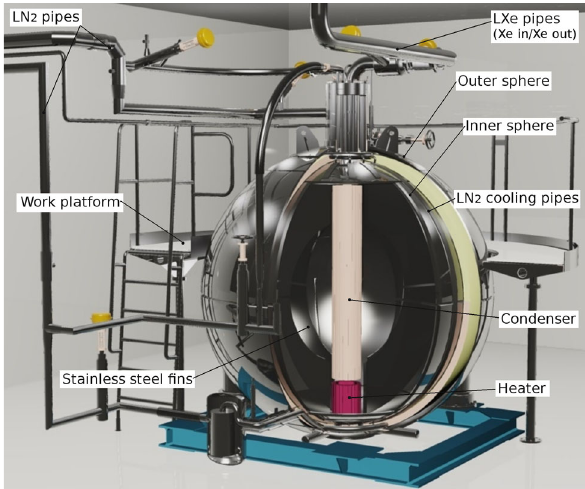
Fig. 10 Drawing of the xenon storage facility ReStoX, which can hold upto7.6tofxenoninliquidorgaseousstate.Thecondenserinthecenter of the 2.1m diameter sphere provides > 3kW of cooling power (for purification of the gas in ReStoX). The latter also pro- vides access to the distillation column (for 85 Kr removal, see Sect. 2.2.3). All components of the gas-handling sys- tem, their relative placement and connections are shown in Fig. 9. ReStoX is installed on the ground floor, about 7m below the top of the detector. The pumps of the purifica- tion system are used to transfer the xenon into the cryostat in a controlled way, at a speed of up to 50slpm: the LXe is evaporated in the ReStoX heat exchanger, purified, re- condensed in the same exchanger and transferred to the cryo- stat. The recovery of xenon into ReStoX via direct vacuum- insulated lines is driven by the pressure difference in the two systems. In case of emergency or for any recupera- tion of Xe gas, the detector pressure can be reduced within O (1)minute. Table 2 Summary of the sources contributing to the background of XENON1T in a fiducial target of 1.0t and a NR energy region from 4 to 50keV (corresponding to 1 to 12keV ER equivalent). The expected rates are taken from the Monte Carlo simulation-based study [19] and assume no ER rejection. The 222 Rn and nat Kr concentrations were measured in XENON1T. CNNS stands